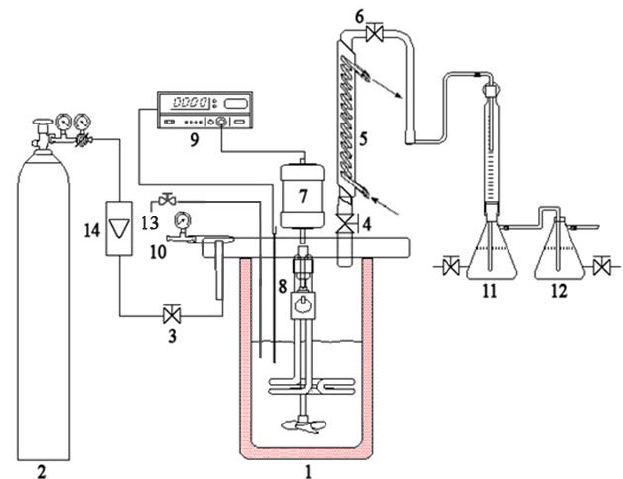
Figure 8. Schematic diagram of the experimental apparatus. 1: Autoclave; 2: nitrogen cylinder; 3: